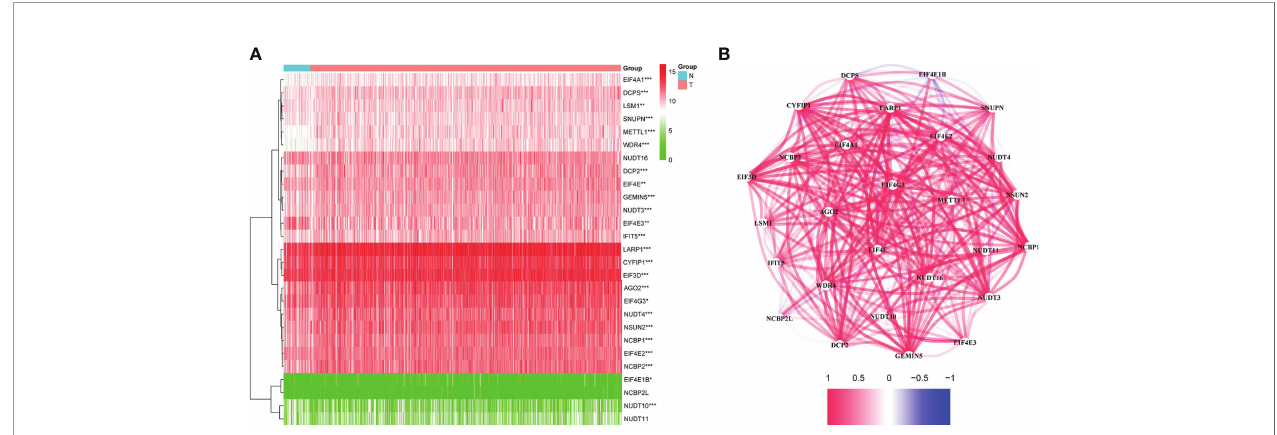
FIGURE 2 | (A) Heatmap of the differential m7G-related genes expression in the two groups. (B) The relationship between m7G -related DEGs. ns, p > 0.05; *p < 0.05; **P <0.01; ***p <